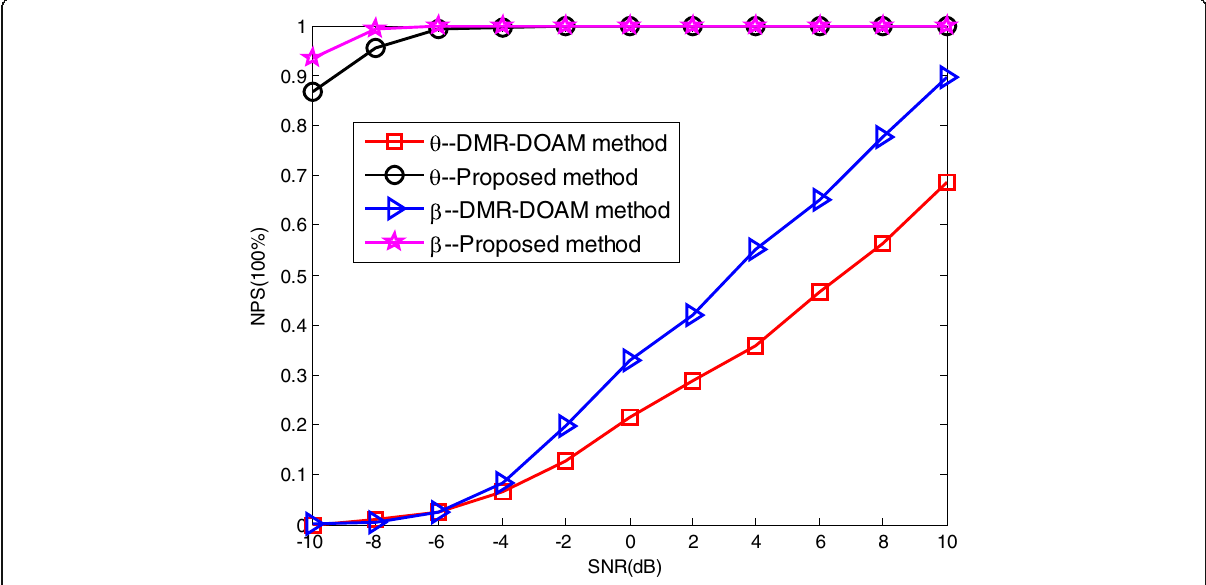
Fig. 3 The NPS of the DOA estimates versus input SNR